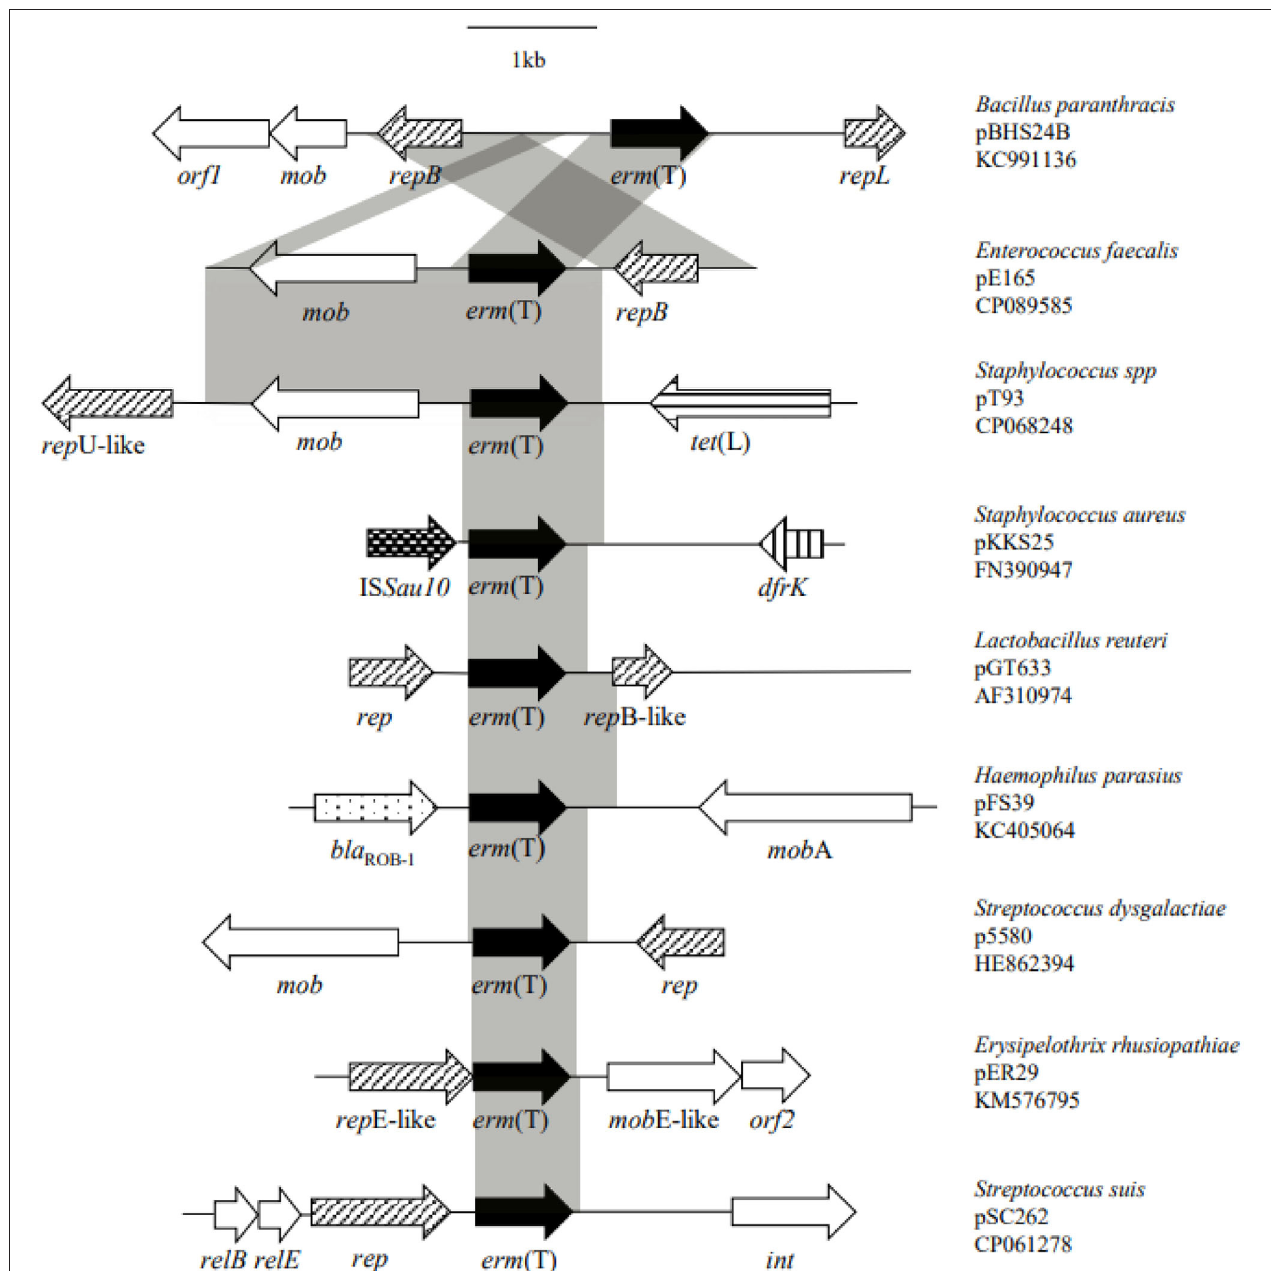
FIGURE 1 | Structural comparison of the genetic environment of erm (T) gene located on pE165 with the genetic environment of erm (T) published previously.